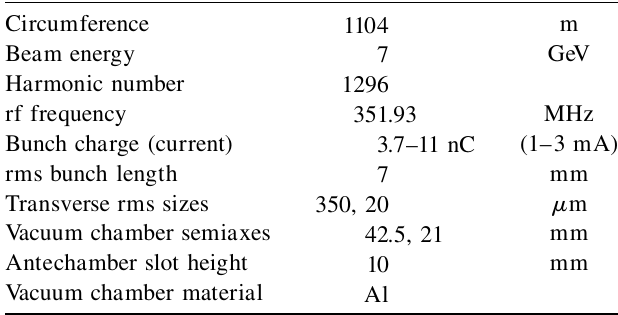
TABLE I. Typical parameters for APS electron-cloud